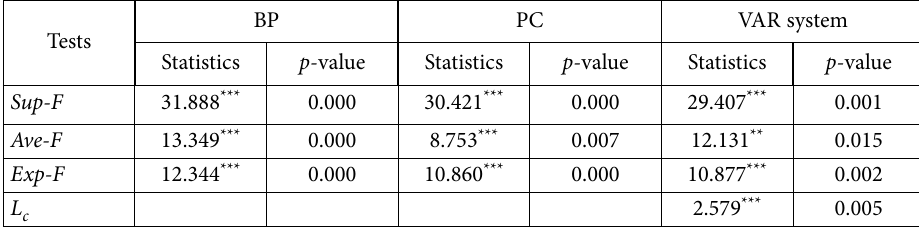
Table 3. The results of parameter stability